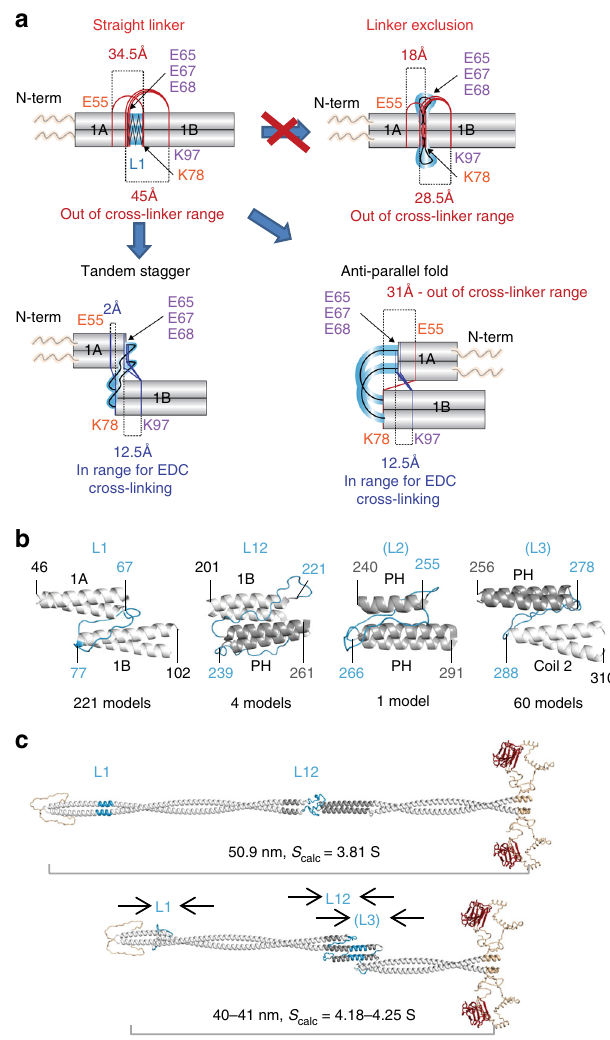
Fig. 7 Modelling of cross-links across linker regions can explain rod shortening. a Principal example models explaining rod shortening around linker L1. Residues in cross-linked pairs E55-K78, E65-K97 (both coil-1A-to- coil-1B) and E67/68-K97 (both L1-to-coil-1B) are too far away from each other (34.5, 48, 45 and 43.5 Å respectively) if L1 is assumed to be α -helical (Straight linker model). Complete exclusion of linker L1 would shorten the rod but is insuf fi cient for bringing cross-linked residues within range for EDC cross-linking (Linker exclusion model). In contrast, tandem stagger folding of the ends of coiled coils over one another or an anti-parallel folding in a U-shape can accommodate the cross-linker constraints and so could explain rod shortening. The tandem stagger model implies a role of the linker in sliding the coiled coil segments onto each other. b Example tandem stagger models with stable coiled coil termini interfaces (I_sc < − 5.0) generated via cross-link-driven docking in Rosetta with Xwalk validation and linkers reconstructed with SWISS-MODEL or MODELLER that support the linear rod shortening via coil sliding. c Model of distended linear lamin A dimer and an example model of dimer compressed via three sequential tandem staggers. When the tandem stagger is applied to three linkers in the rod it can shorten the rod from 50.9 nm to 40 – 41 nm, consistent with measurements obtained from analytical ultracentrifugation. S calc determined using SoMo (Supplementary Fig. 6 and Source Data fi